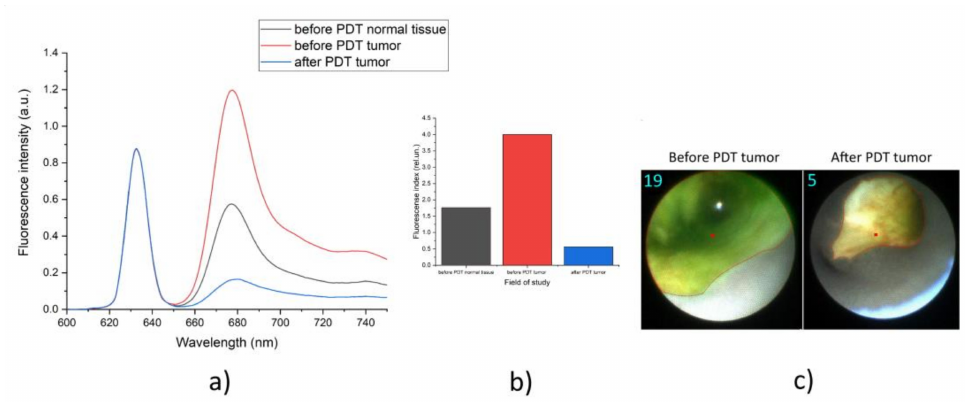
Figure 3. ( a ) Spectral curves of the PS accumulated in tumor area, ( b ) fluorescence indexes from tumor and normal tissue in the maximum PS accumulation, and ( c ) real image of a bile duct tumor before and after PDT. Fluorescence indexes are marked in the upper left corner.